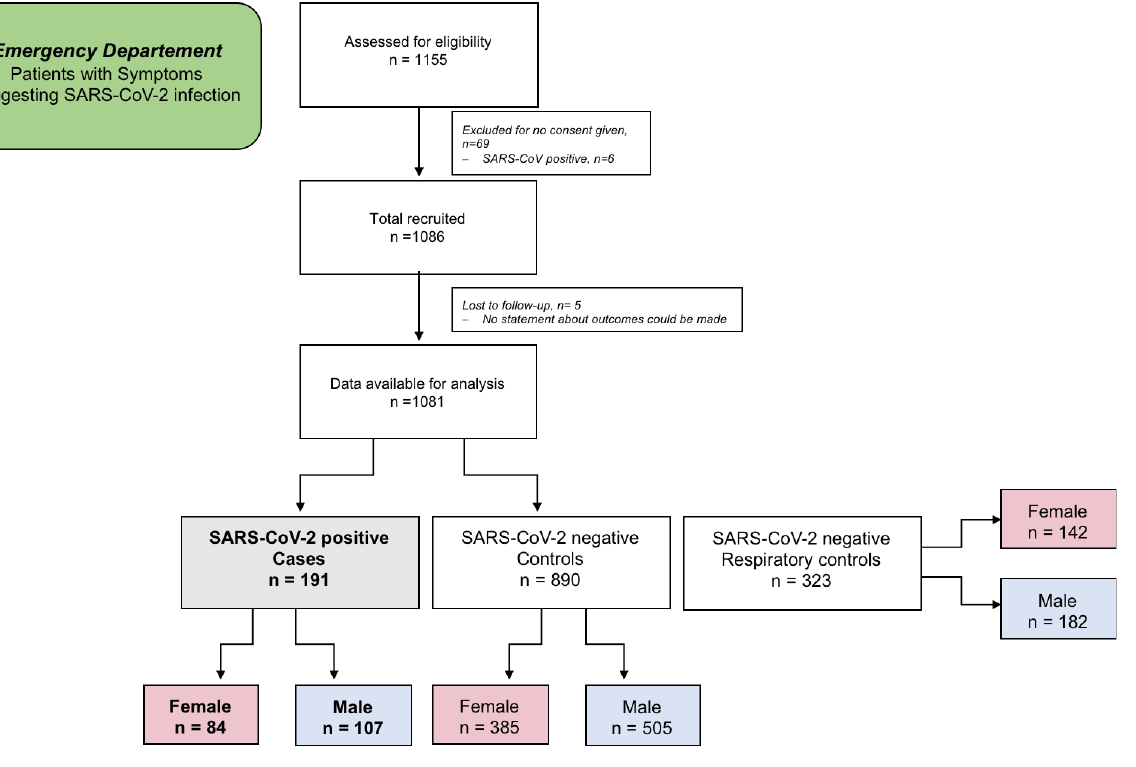
Figure S1: Flow diagram for patient